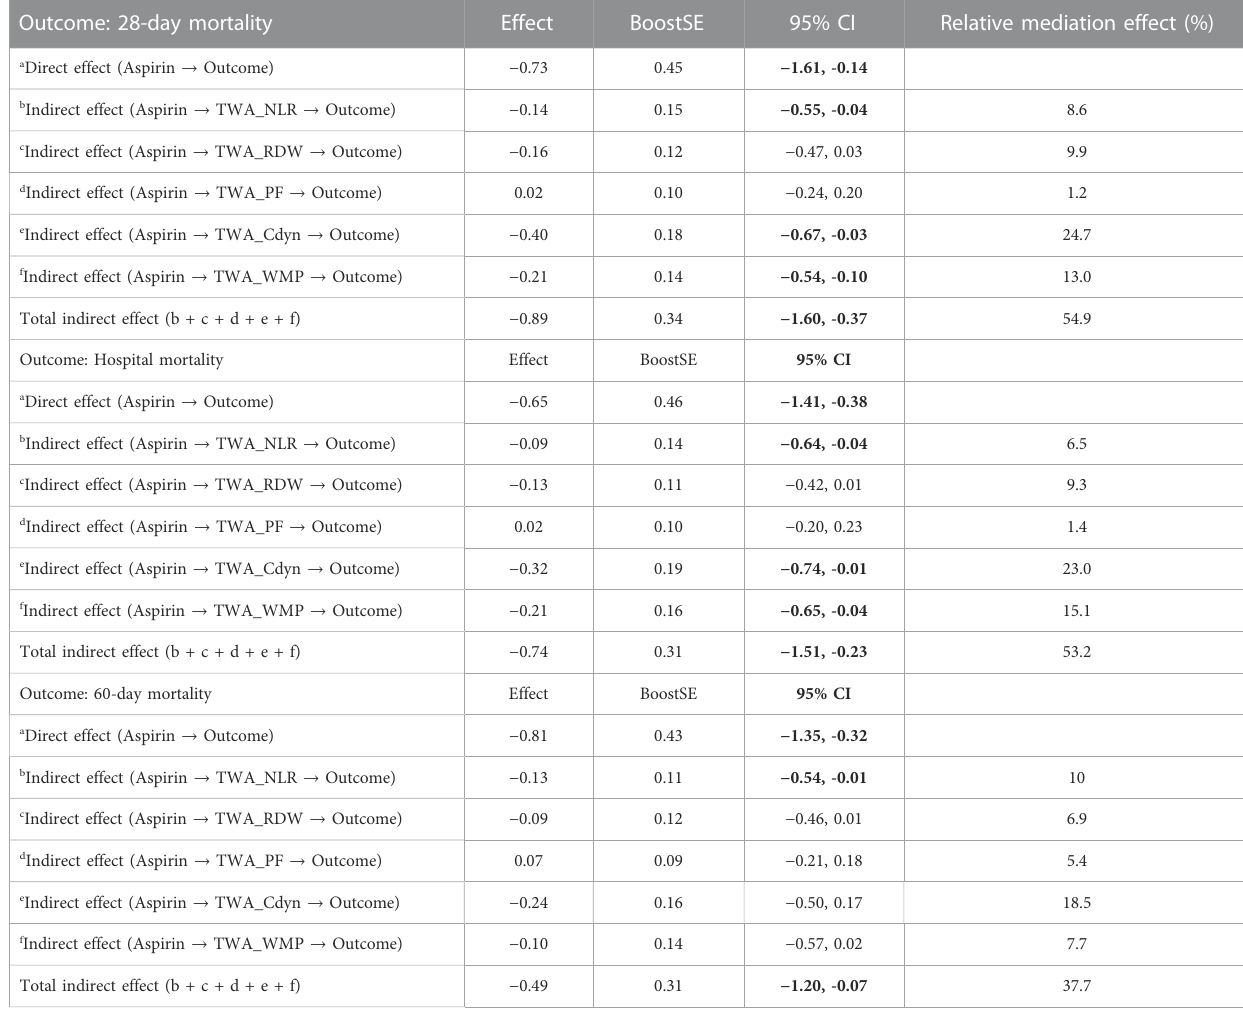
TABLE 3 The effect size of each path in the multiple mediation analysis. Outcome: 28-day